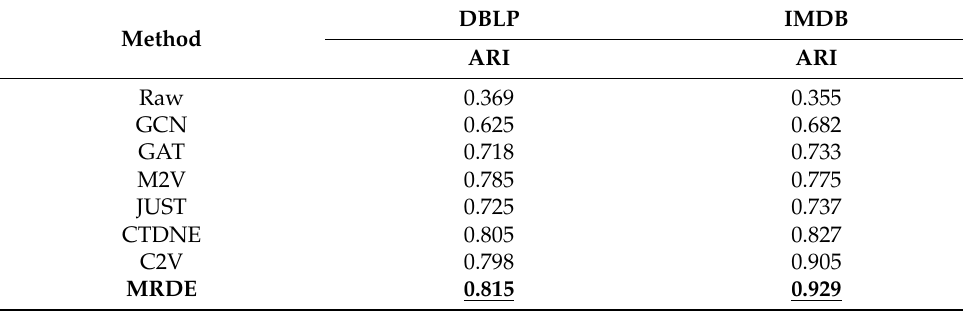
Table 3. Experimental results of node clustering task.